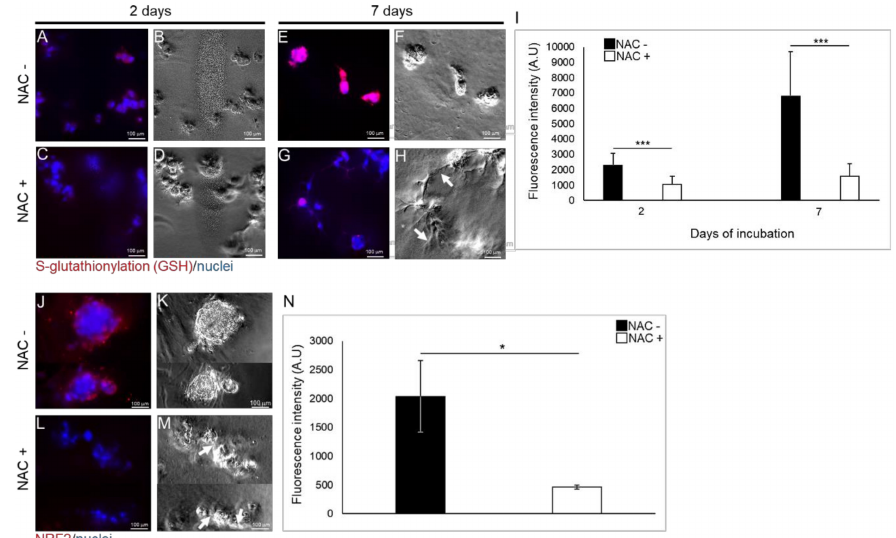
Figure 6. The levels of S-glutathionylation and Nrf2 in growth-arrested versus rescued pulp microtissues at early and advanced stages of development. ( A , C , E , G ) Fluorescence stock photos and ( B , D , F , H ) phase-contrast images of growth-arrested spherical microtissues after ( A , B ) 2 d and ( E , F ) 7 d versus growth-resumed pulp microtissues treated with NAC after ( C , D ) 2 d and ( G , H ) 7 d. White arrows point to the interactions between the spherical structures. ( I ) Bar graph measuring the fluorescence intensity of the GSH marker (S-glutathionylated proteins). *** p ≤ 0.001. ( J , L ) Fluorescence and ( K , M ) phase-contrast images of ( J , K ) growth-arrested spheroids versus ( L , M ) growth-resumed pulp microtissues treated with NAC. White arrows point to the interactions between the spherical structures. ( N ) Bar graph measuring the fluorescence intensity of Nrf2 marker. * p ≤